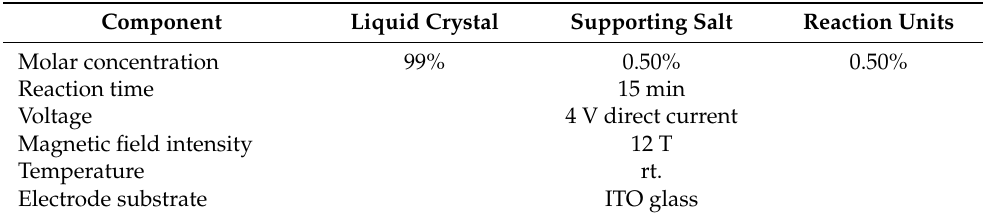
Table 1. Concentration of each component of the electrolyte solution and the electrochemical poly- merization conditions. Component Liquid Crystal Supporting Salt